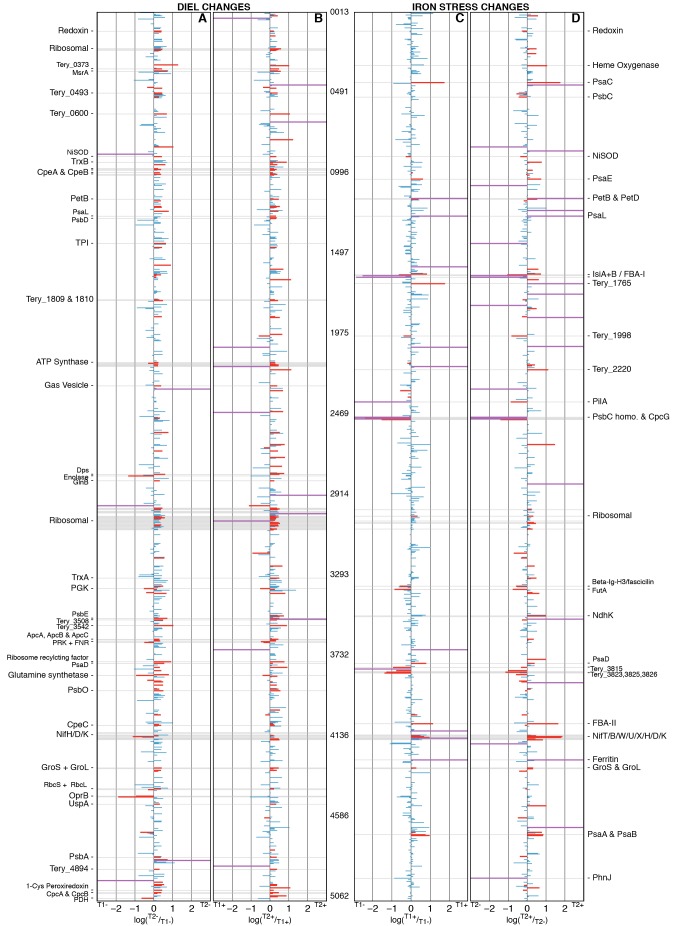
Overview of between-treatment changes in protein abundance.Overview depicting between-treatment changes in protein abundance. Plots A and B show the diel proteomic changes for T1-/T2- and T1+/T2+ respectively. Plots C and D show Fe stress induced proteomic changes for T1-/T1+ and T2-/T2+, respectively. Significant and non-significant changes in protein abundance are colored in red and blue, respectively. The 1104 observed proteins are ordered sequentially along a linear plot of the chromosome and annotated with T. erythraeum IMS101 locus tags or protein abbreviation/description. Proteins of particular interest are labelled, with some proteins appearing as abbreviations found throughout the text. Proteins for which we observed a statistically significant presence/absence response are plotted as a nominal fold change coloured in purple. Further detail on proteins showing a statistically significant change in abundance can be found in Tables A-D in S1 Data.